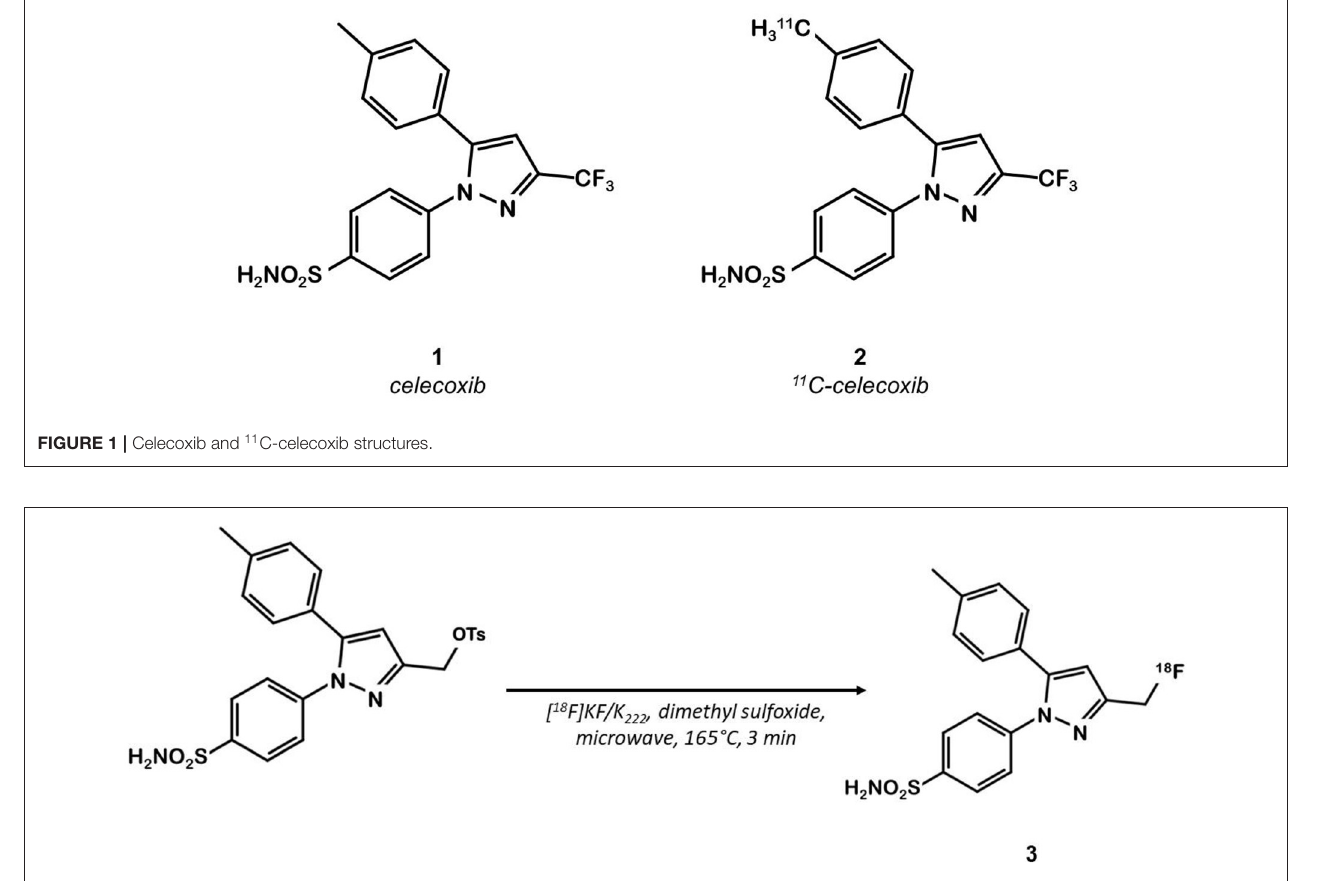
FIGURE 2 | Radiosynthesis of pyrazole derivative 18 F-3.